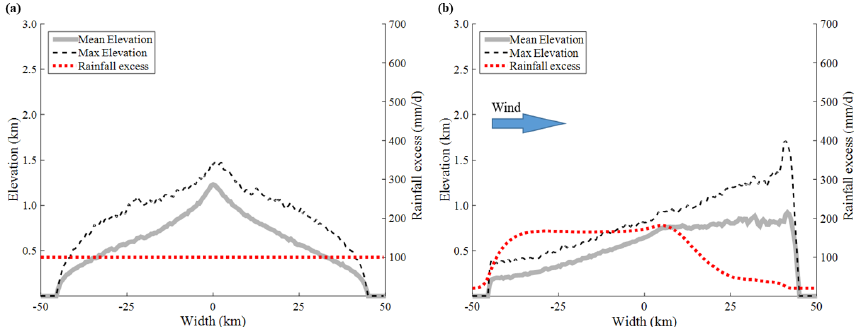
Figure 3. North–south transects of landscapes and rainfall fields after 5Ma simulation times. Results from (a) no-feedback ( P = 100mmd − 1 ) and (b) co-evolution ( V = 16ms − 1 , t d = 1200s, t ∗ = 0 . 427) simulations are shown.